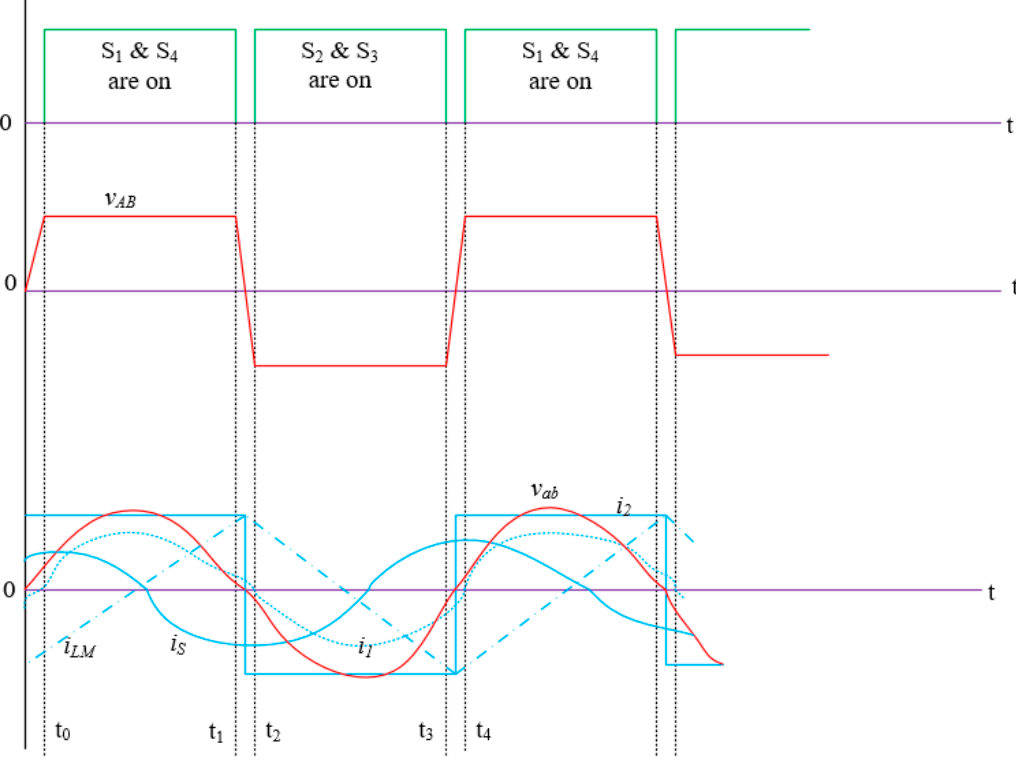
Figure 4. Operating waveforms of the proposed LC-LC2 resonant converter.